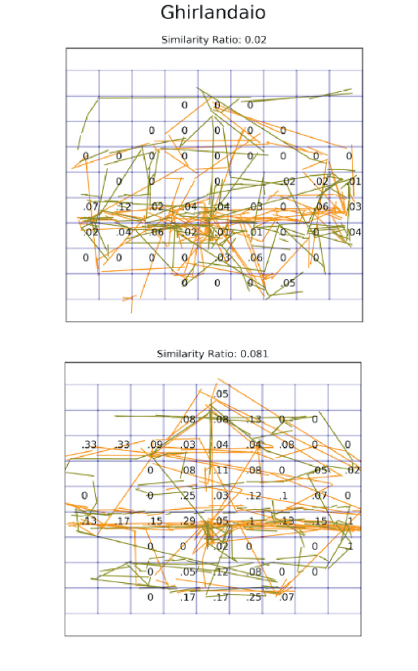
Figure 1. Data Analysis example. A relatively dissimilar (top) and a highly similar (bottom) pair of observers’ saccades during one minute of free viewing are visualized for the same painting (Ghirlandaio). The saccades of each participant are traced in different colors (yellow and green) The blue grid shows the spatial resolution of the calculation (9*9). Each cell shows the similarity ratio of saccadic angles (number of similar pairs of saccades using a threshold of 5° divided by the number of com- parisons). The average similarity ratio is shown in the title. The only cells that were analyzed were those in which both partici- pants had crossed cell boundary